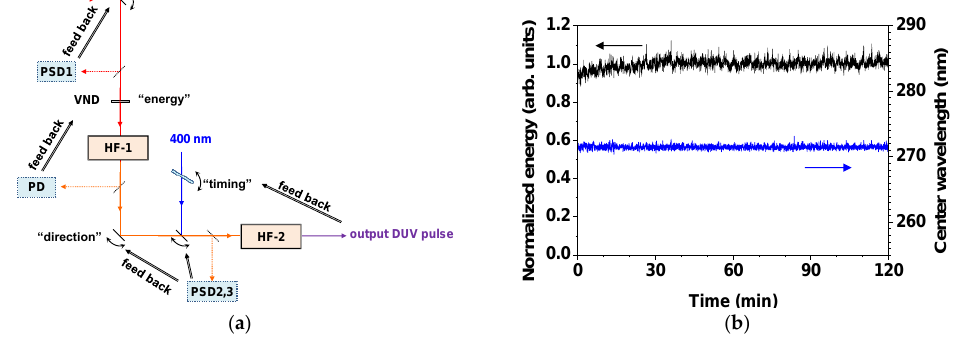
Figure 9. ( a ) Schematic drawing of the stabilization scheme; ( b ) Evolutions of the energy and the central wavelength of the DUV pulse recorded over 2 h after the stabilization.